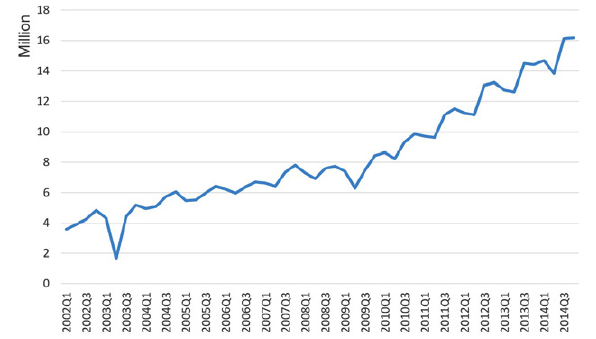
Figure 1. Quarterly Hong Kong tourist volume,